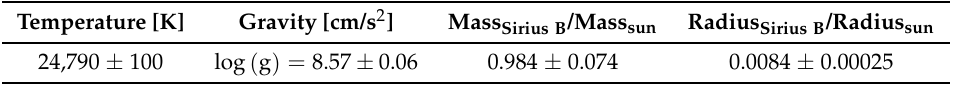
Table 1. Sirius B parameters